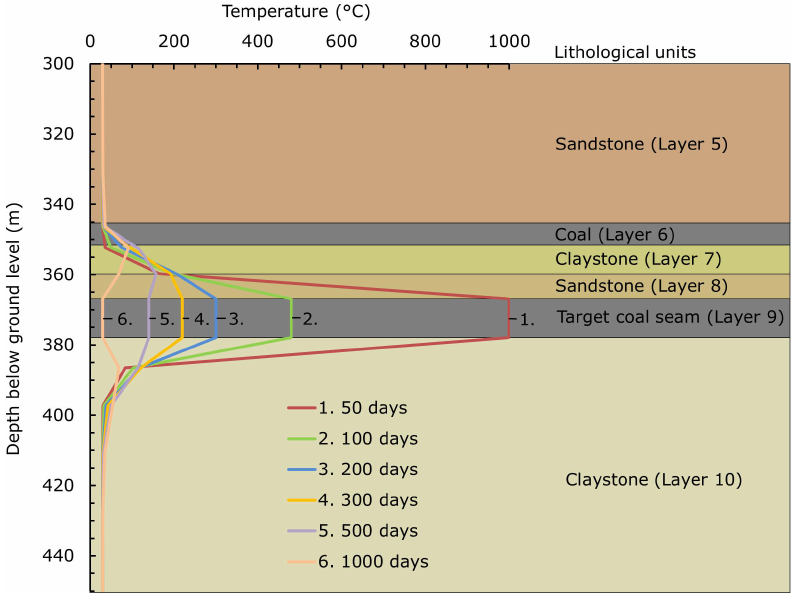
Figure 3. Temperature variation along a vertical profile through the coal seam (Layer 9) at different simulation times. The high temperature ( ≥ 200 ◦ C) region is limited to the close channel vicinity and reaches a maximum extent of 7.5 m after 200 days of simulation above and 50 days below the target coal seam (Layer